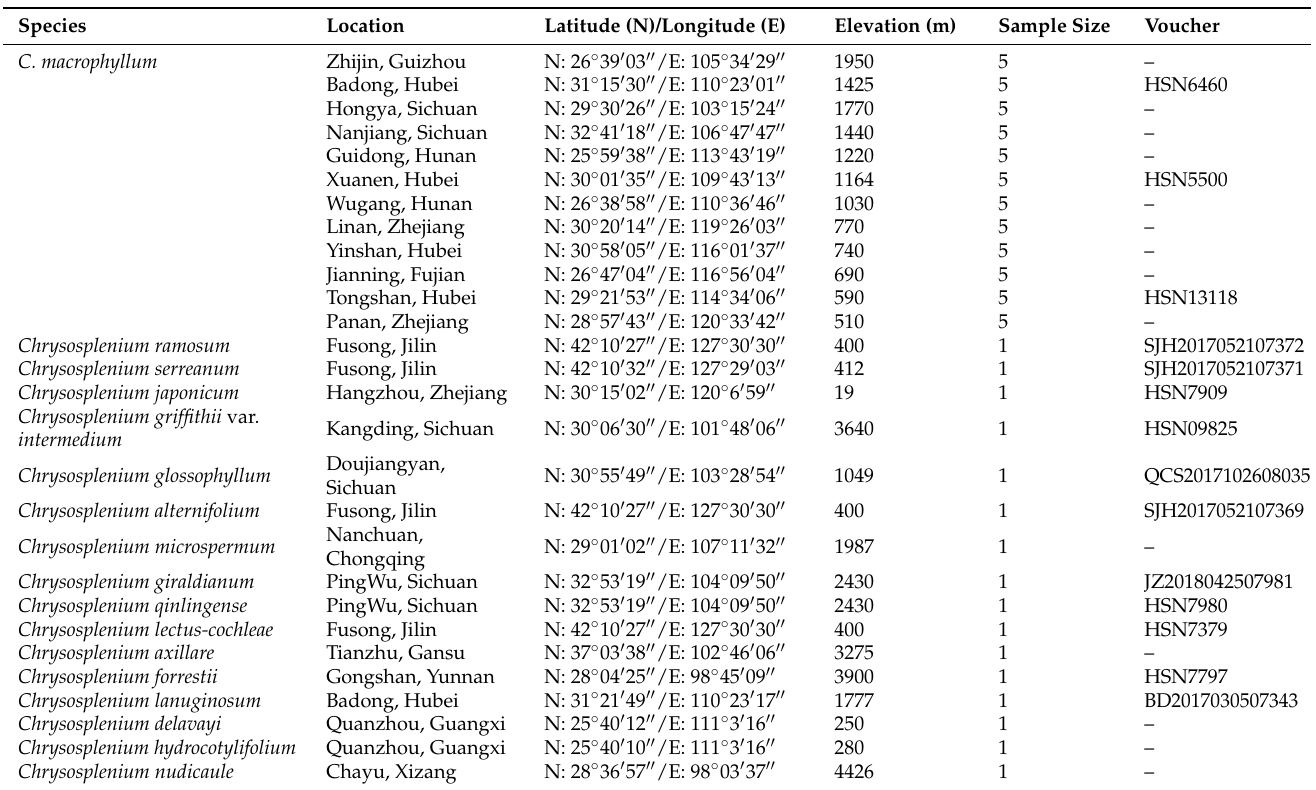
Table 1. Characteristics of analyzed Chrysosplenium species in this